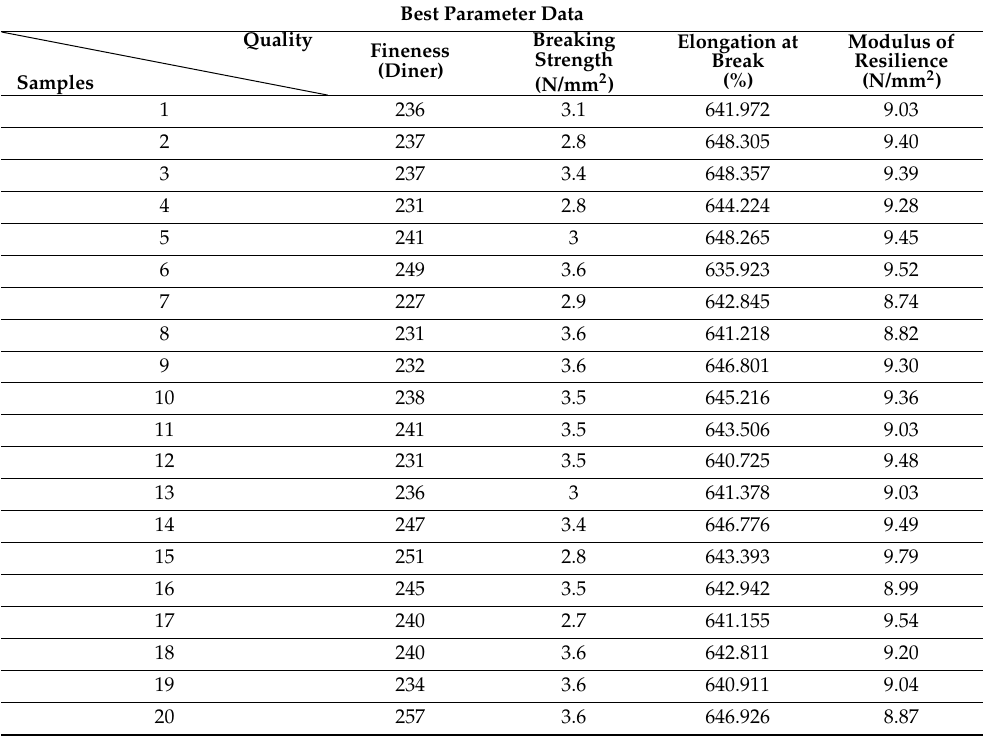
Table 7. Twenty data samples with the best parameters.